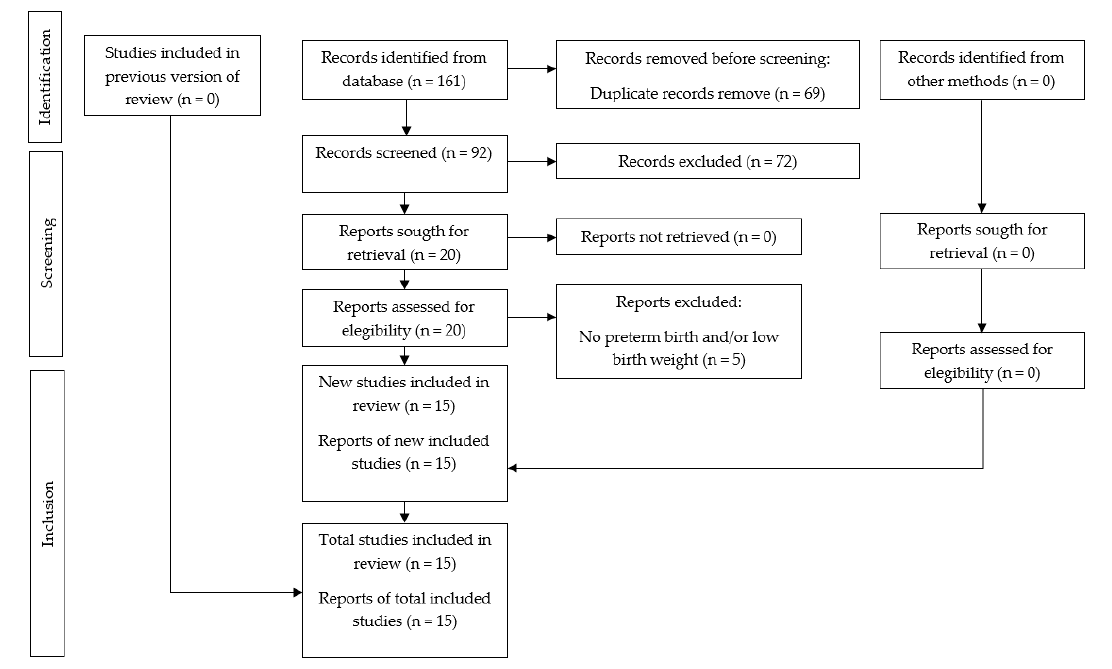
Figure 1. PRISMA flowchart showing the process of inclusion and exclusion of studies in the sys- tematic review. Table 2. Reason for exclusion of included studies.